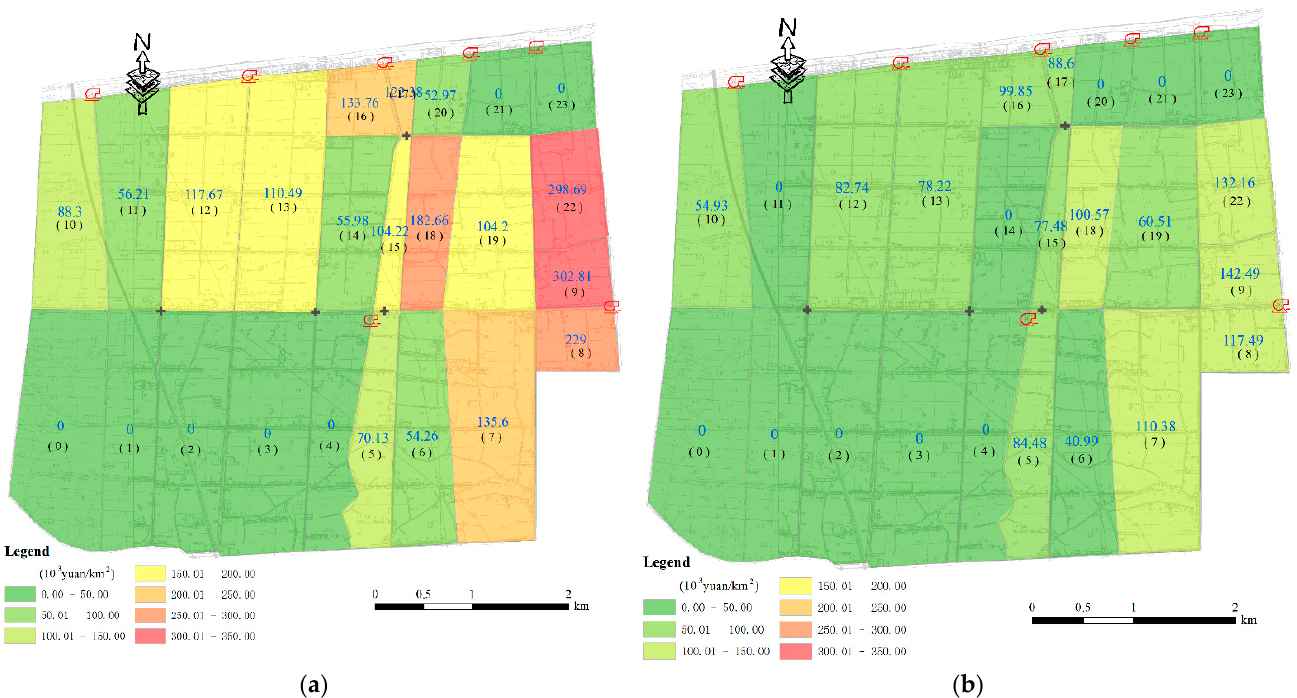
Figure 9. The distribution of paddy losses before and after optimization of Rainfall Event 2. Number in black represents serial number of field and blue represent paddy loss. ( a ) Distribution of flooding losses in original operation. ( b ) Distribution of flooding losses after optimization. (1)–(22) represents numbers of fields.